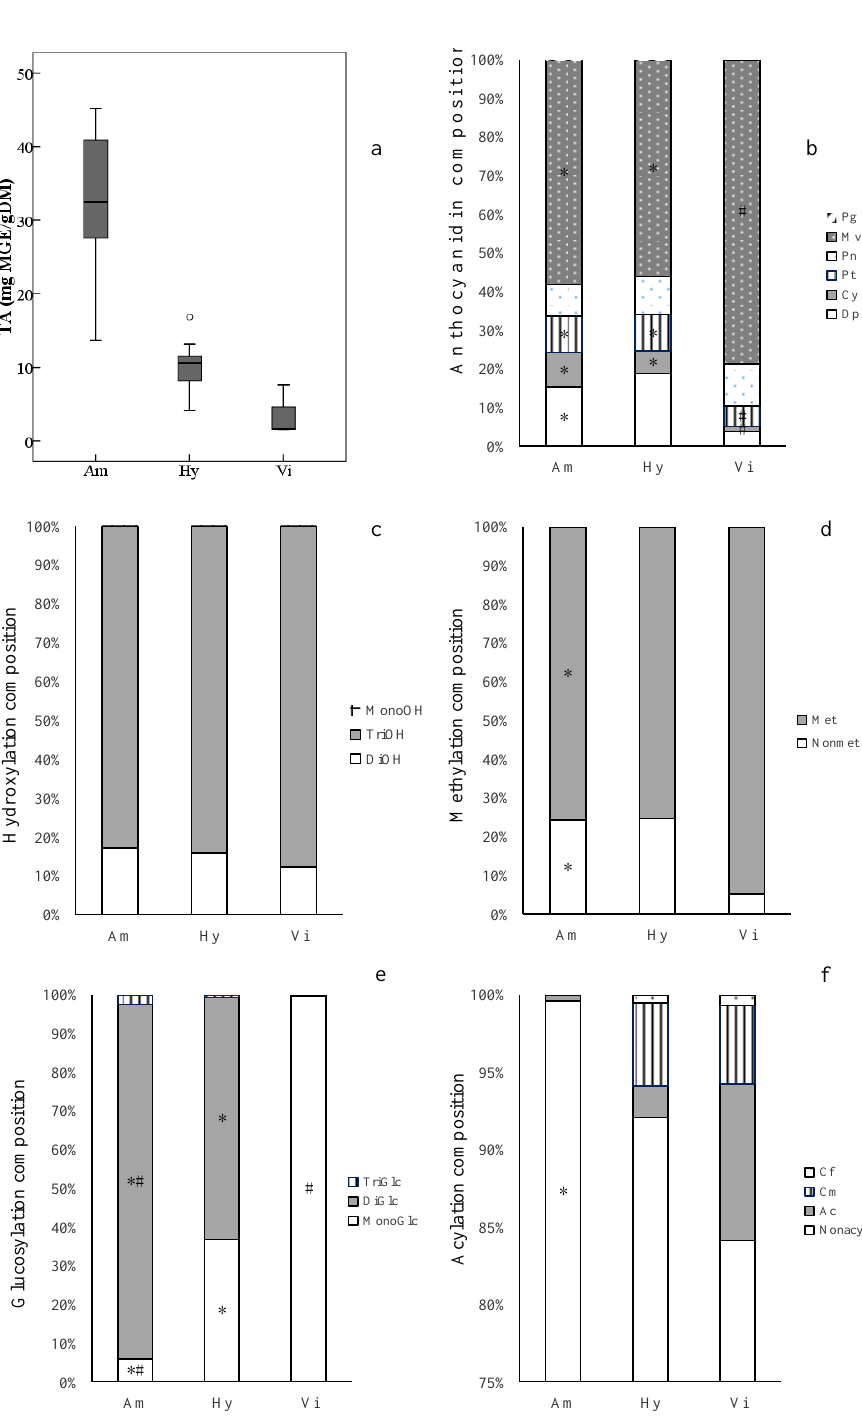
Figure 4. Ranges and distributions of total anthocyanins (TA, a ) and anthocyanin compositionsof anthocyanidin ( b ), hydroxylation ( c ), methylation ( d ), glucosylation ( e ) and acylation ( f ) in ripe berry skins belonging to the three grape groups from 2017 2018. * indicates significant difference ( p < 0.05) vs. V. vinifera grapes for each indicator by Welch’s ANOVA with the Games–Howell test. # indicates significant difference ( p < 0.05) vs. interspecific hybrids. Abbreviations: Dp, delphinidin derivatives; Cy, cyanidin derivatives; Pt, petunidin derivatives; Pg, pelargonidin derivatives; Pn, peonidin derivatives; Mv, malvidin derivatives; MonoOH, monohydroxylated anthocyanins; DiOH, dihydroxylated anthocyanins; TriOH, trihydroxylated anthocyanins; Met, methylated anthocyanins; Nonmet, nonmethylated anthocyanins; MonoGlc, monoglucoside anthocyanins; DiGlc, diglucosides anthocyanins; TriGlc, speculated triglucosides anthocyanins; Cf, caffeoyl anthocyanins; Cm, coumaryl anthocyanins; Ac, acetyl anthocyanins; Nonacy, nonacylated anthocyanins. The abbreviations of grape groups follow Figure